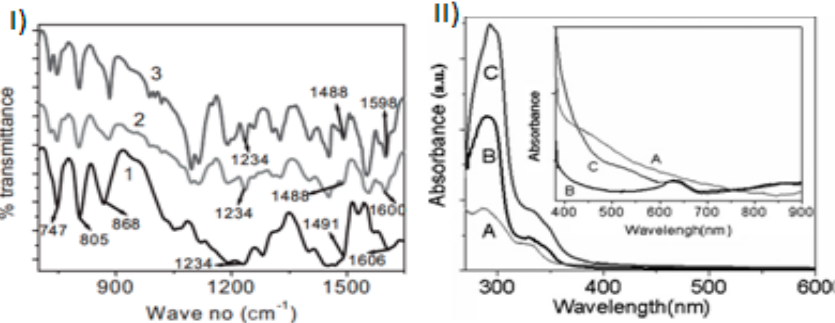
Figure 7. ( I ) FT-IR spectra obtained of (1) pure PCz (2) PCz–Au nanocomposite (by emulsion) and (3) PCz–Au nanocomposite (by interfacial polymerization). ( II ) UV–Visible spectra of (A) Pure PCz, (B) PCz–Au nanocomposite (by emulsion) and (C) PCz–Au nanocomposite (by interfacial polymerization). Inset: Zoom for small peak due to the gold particles (600–620 nm) and broad absorption band onward 750 nm. Reprinted with permission from Gupta et al. [104]. Copyright (2012) Wiley.